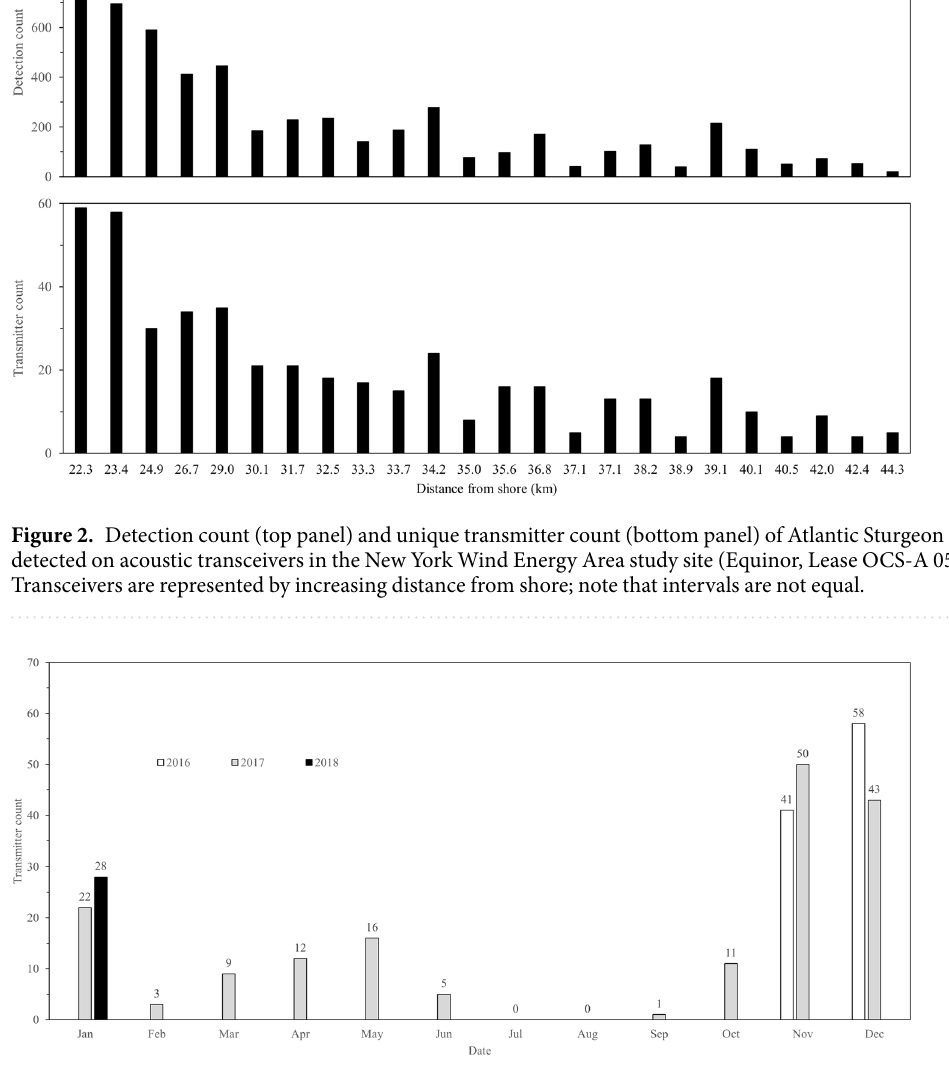
Figure 3. Monthly counts of unique Atlantic Sturgeon detected on acoustic transceivers in the New York Wind Energy Area study site (Equinor, Lease OCS-A 0512) from November 2016 through January